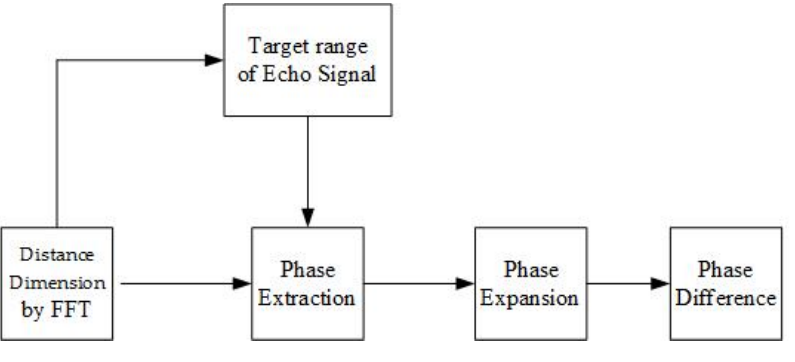
Figure 9. Phase detection flow. 3.3.3. Moving Target Indication (MTI) Filter Designed Algorithm